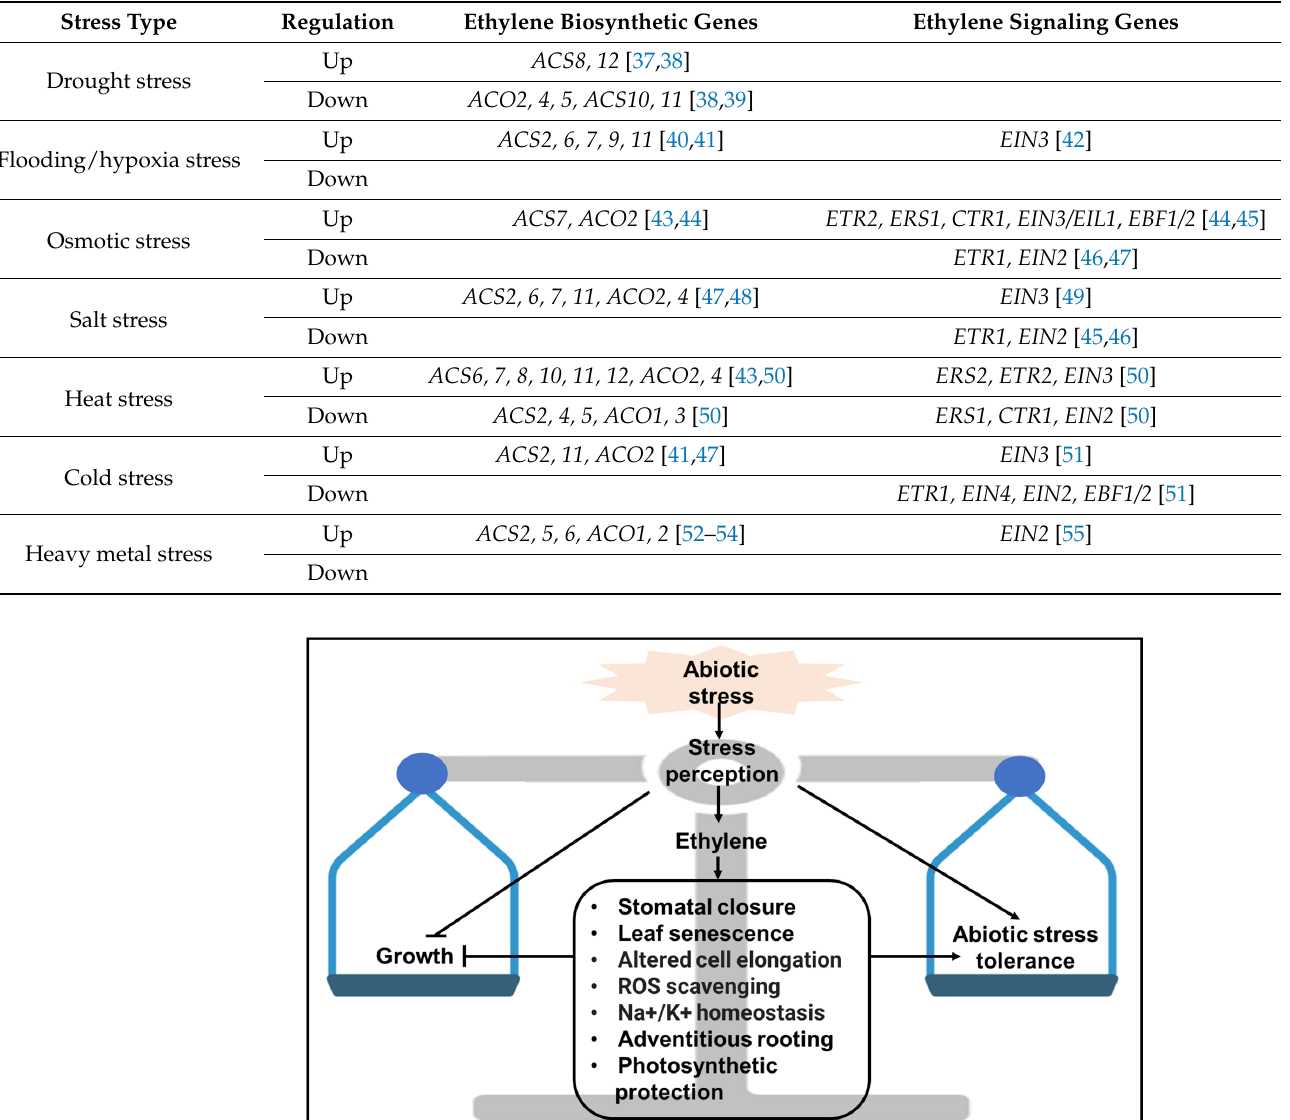
Table 1. Effects of different abiotic stress factors on transcript abundance of ethylene biosynthetic and signaling genes in